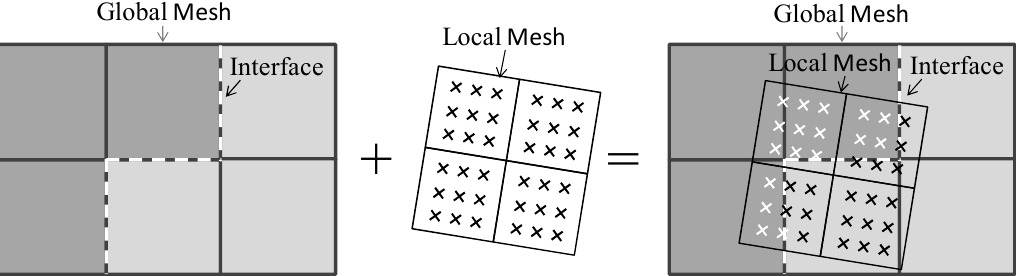
Figure 2: Global mesh and local mesh in heterogeneous